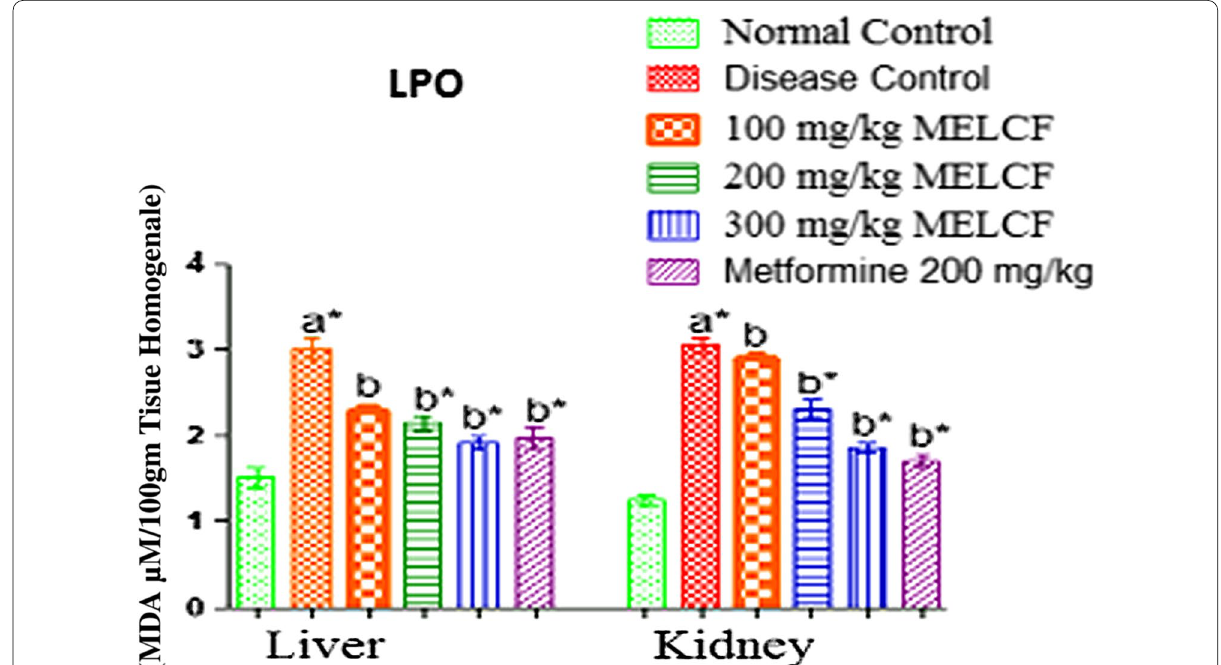
Fig. 12 Effect of MELCF on LPO. The values represented as mean when compared to disease/diabetic